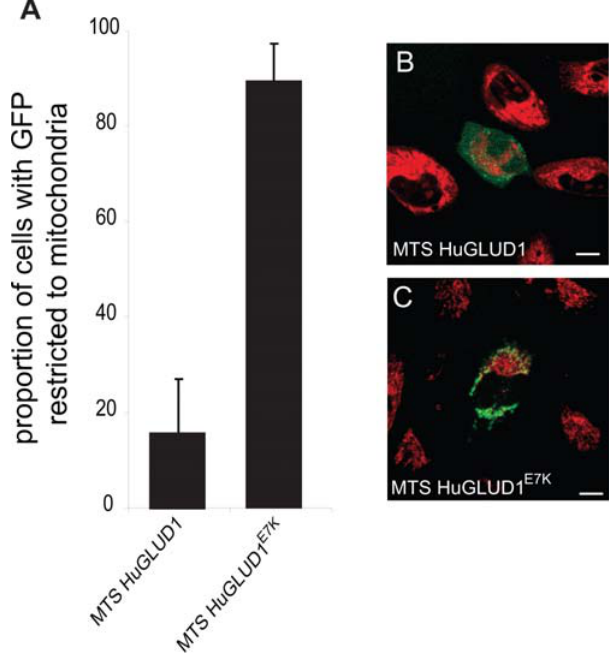
Figure 4. Subcellular Localization of Wild-Type and Mutant GLUD1 MTS. (A) Proportion of transfected LN229 cells with GLUD-GFP signals detected only in mitochondria. HuGLUD1 E7K shows significantly higher mitochondrial localization specificity than HuGLUD1 ( P , 0.01, Tukey’s Post Hoc test). (B) and (C) LN229 cells transfected with GLUD1 and GLUD1 E7K GFP fusion constructs, respectively (mitochondria labeled with MitoTracker, red). Scale bars=10 m m. Unmerged images are shown in Figure S4.